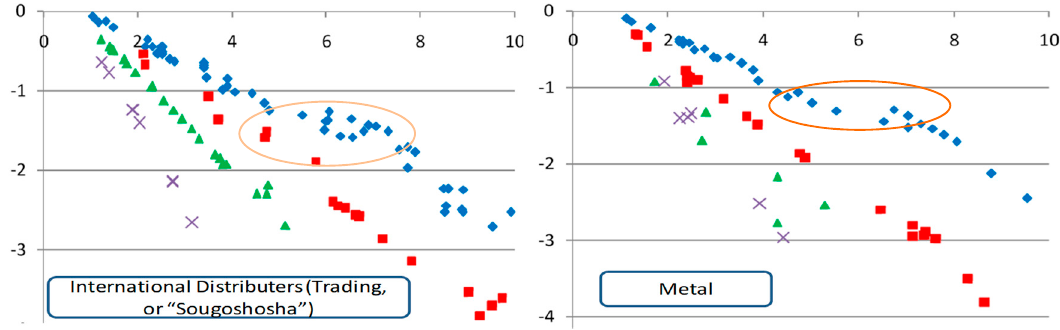
Figure 8. CRiPS-plots of credit rating groups in international distribution (trading) and steel/nonsteel/mining (metal) industries.